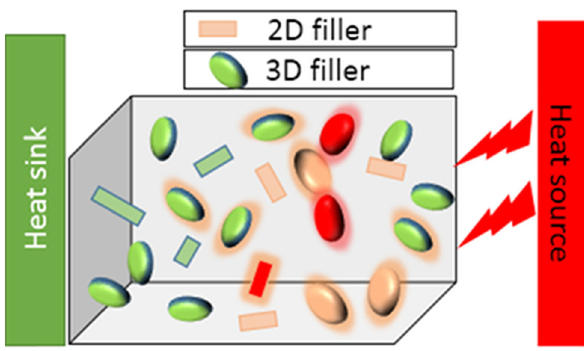
Figure 8: Symmetrically represent hybrid fi ller heat transfer mechanism in the polymer